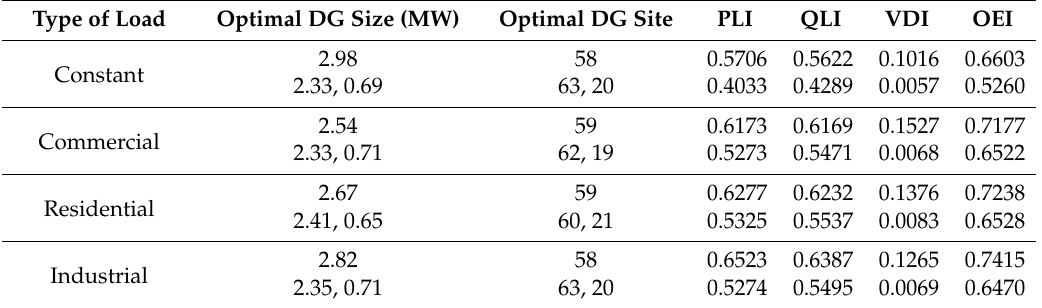
Table 4. Optimal size and site of DG and Indices values for voltage deviation index (VDI) as objective. Type of